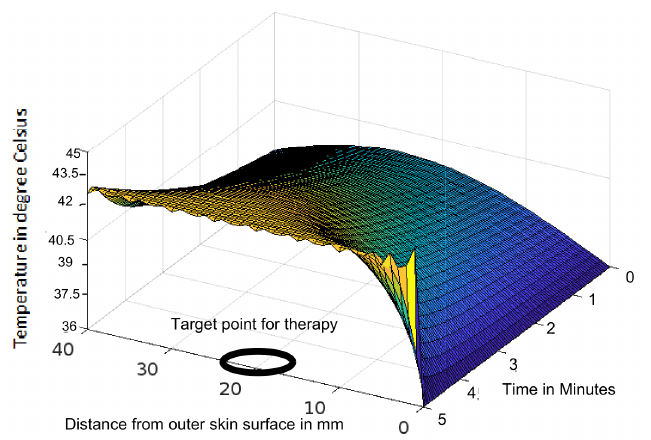
Figure 1. Variation of temperature profiles during thermotherapy at a temperature of 43 ◦ C targeted to a tumour located in a human head.